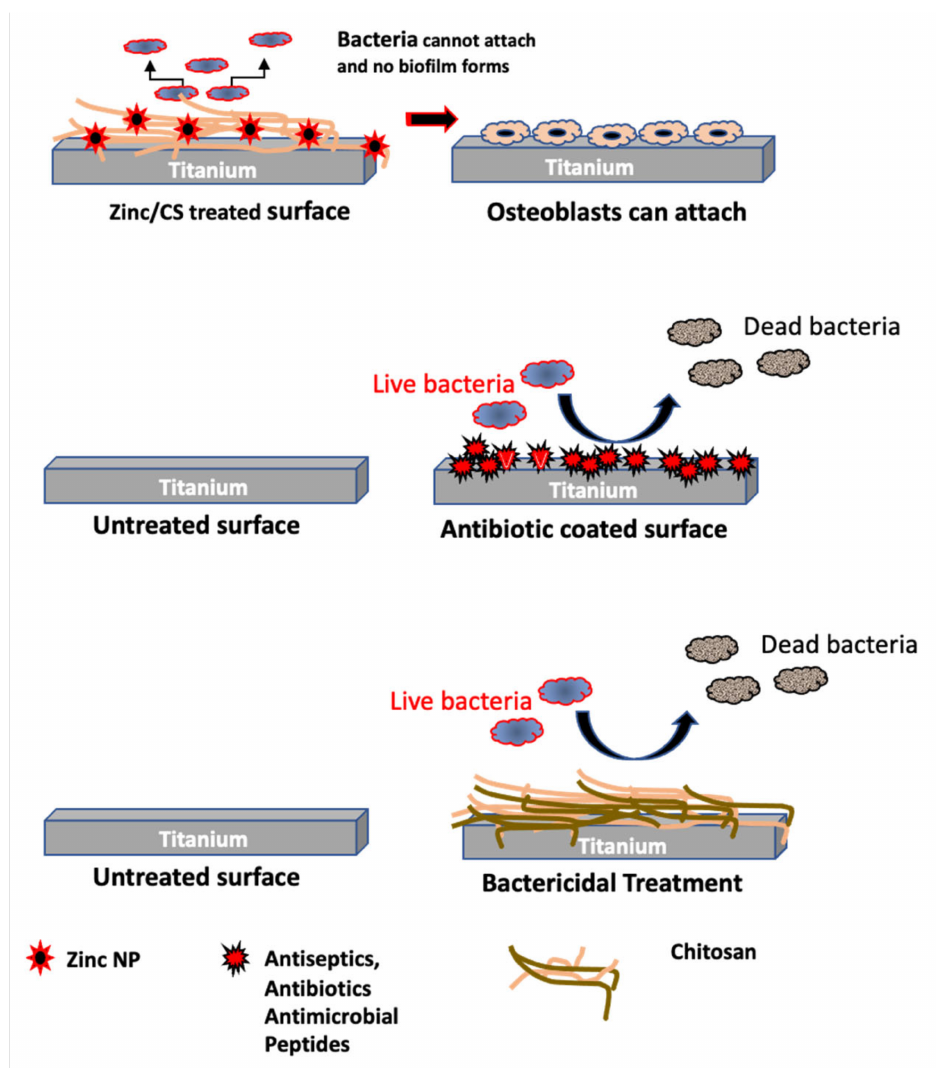
Figure 5. Surface modifications of surfaces can create bacteria-repellent